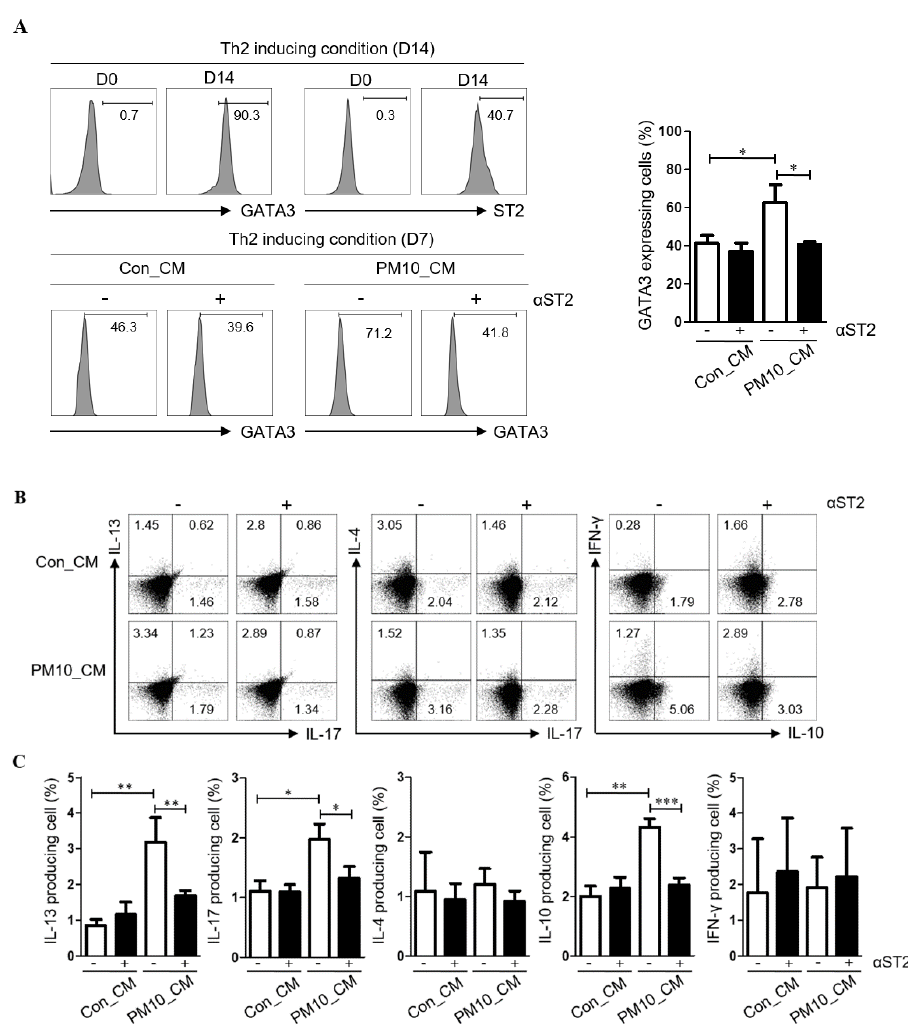
Figure 5. The pivotal effect of PM10-induced IL-33 for Th2 differentiation effects of conditioned media on PM10-induced human nasal polyp derived fibroblast (NPDFs-CM) on the inflammatory cytokine production in CD4 + T cells. ( A ) Th2 differentiation was determined by the expression of GATA3 and ST2 (IL-33 receptor). ( B , C ) The protein levels of IFN- γ , IL-17A, IL-4, IL-13, and IL-10 in CD4 + T cell populations were determined by flow cytometry according to the addition of ST2. The graphic data represents the means ± SEM ( n = 3). * p < 0.05, ** p < 0.01, *** p < 0.0001 as compared to the PM10-treated